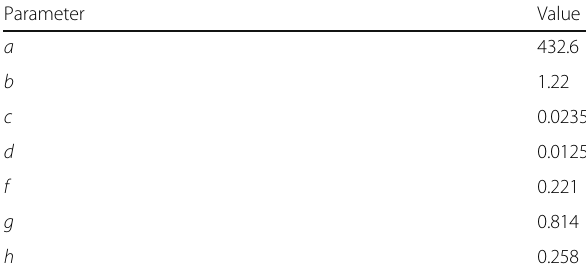
Table 8 Parameter values used in sub-model 2 (from Table 7, Kimberley et al.